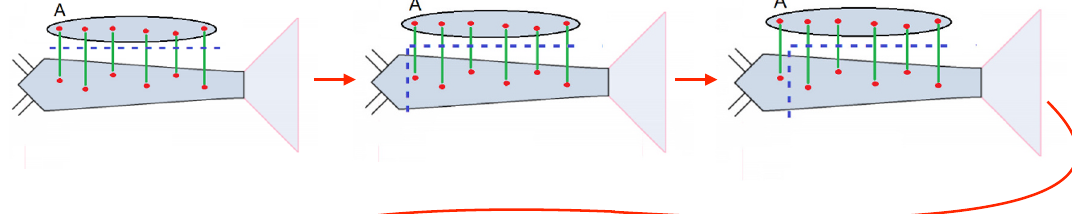
Figure 13 . The ‘expandable space blimp’. The one-sided wormhole from (cid:12)gure 12, now showing the bulk entanglement connecting the distant Hawking particles to their anchor points on the red dots.